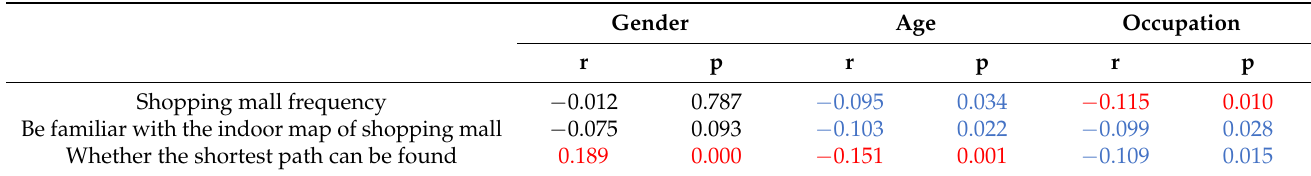
Table 8. Correlation analysis between characteristics (personal basic information) and status variables (objective data) 1 .